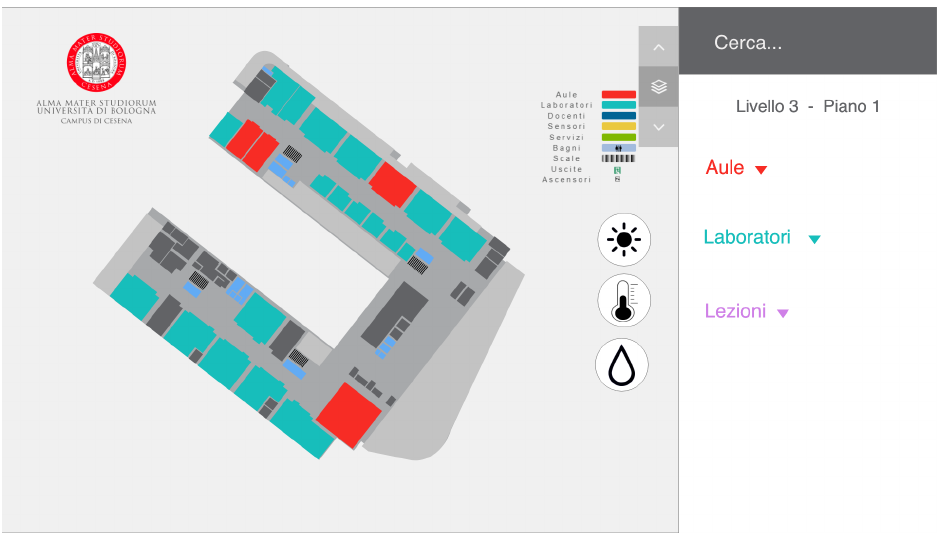
Figure 4. The homepage of the two prototypes with the three icons on the left that showed the three types of sensor data to visualize (brightness, temperature, and humidity).